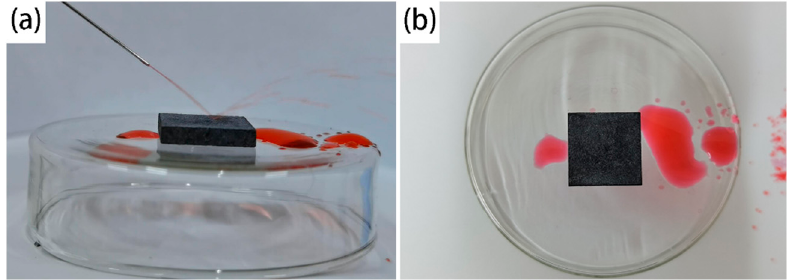
Figure 10. Bouncing performance of the SMA surface. ( a ) Red ink bouncing; ( b ) No residual liquid on the surface.